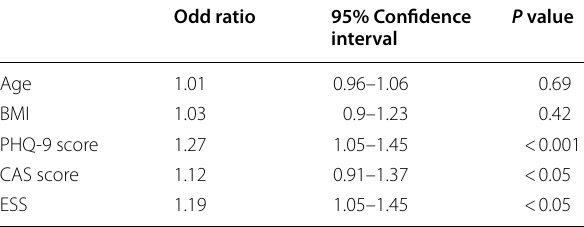
Table 4 Multiple logistic regression to assess predictors of PSQI score in patients with